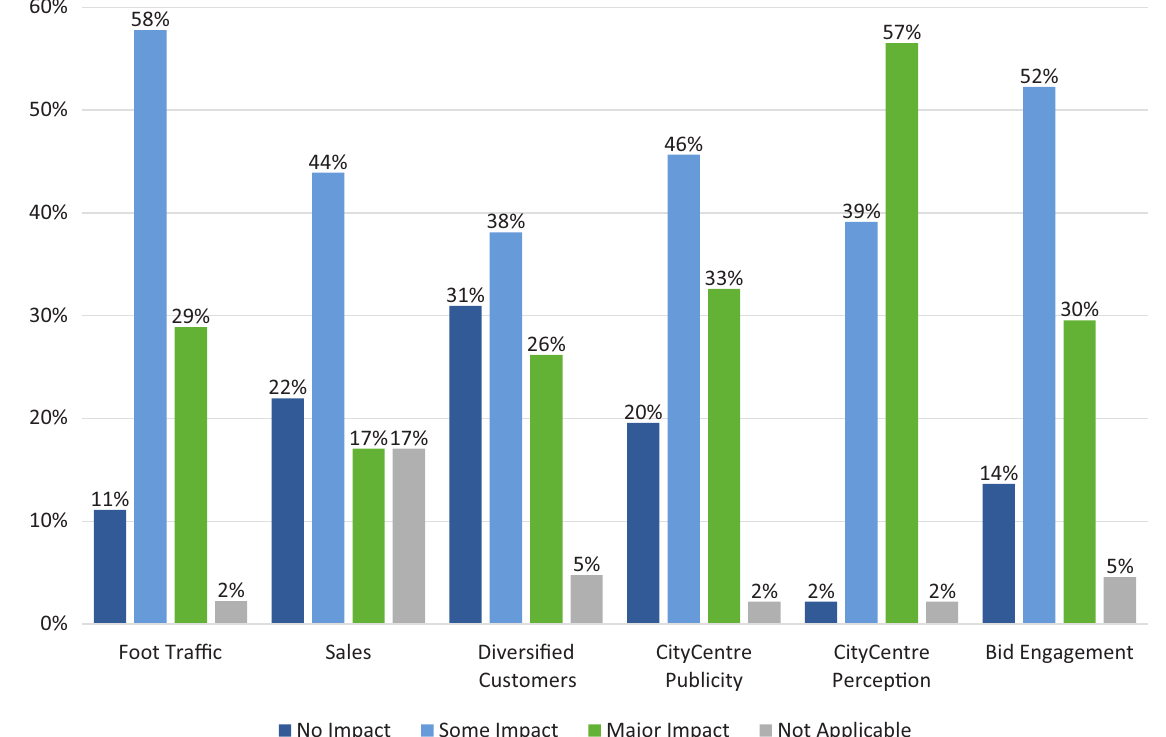
Figure 1. Perceptions of economic impact by city‐centre businesses. the perception of the city centre, a finding reinforced by the participant survey. Additionally, according to team members, the festival production crew and suppliers were all locally sourced, supporting existing research regarding the relationship between festivals and local economies (Freire‐Gibb & Lorentzen, 2011; Hassink & Lee,